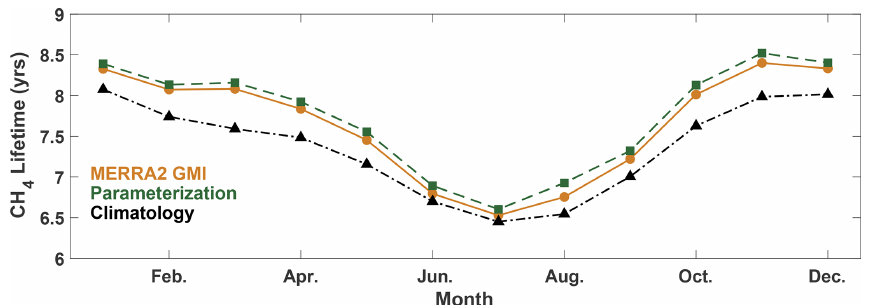
Figure 4. Global mean methane lifetime with respect to tropospheric OH from the parameterization (green squares) and MERRA2 GMI (orange circles) for 2005 and the climatological average (black triangles) calculated from MERRA2 GMI for 1980–2019.